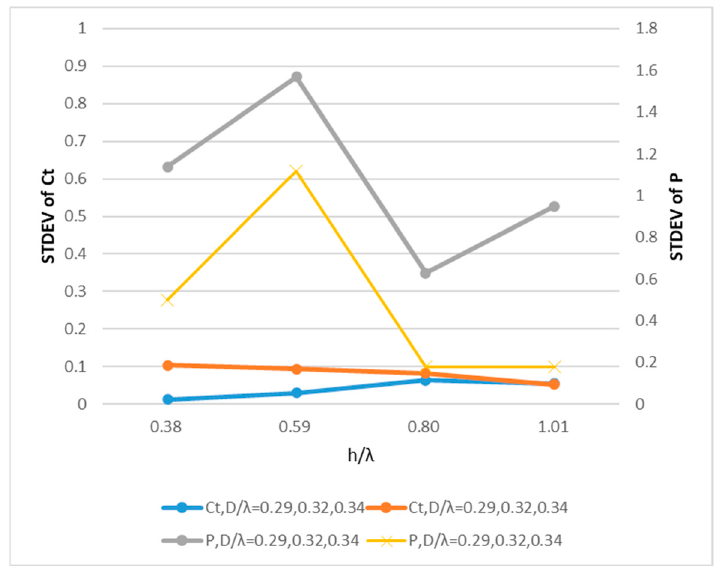
Figure 12. Standard deviation analysis plot with h/ λ as variable.